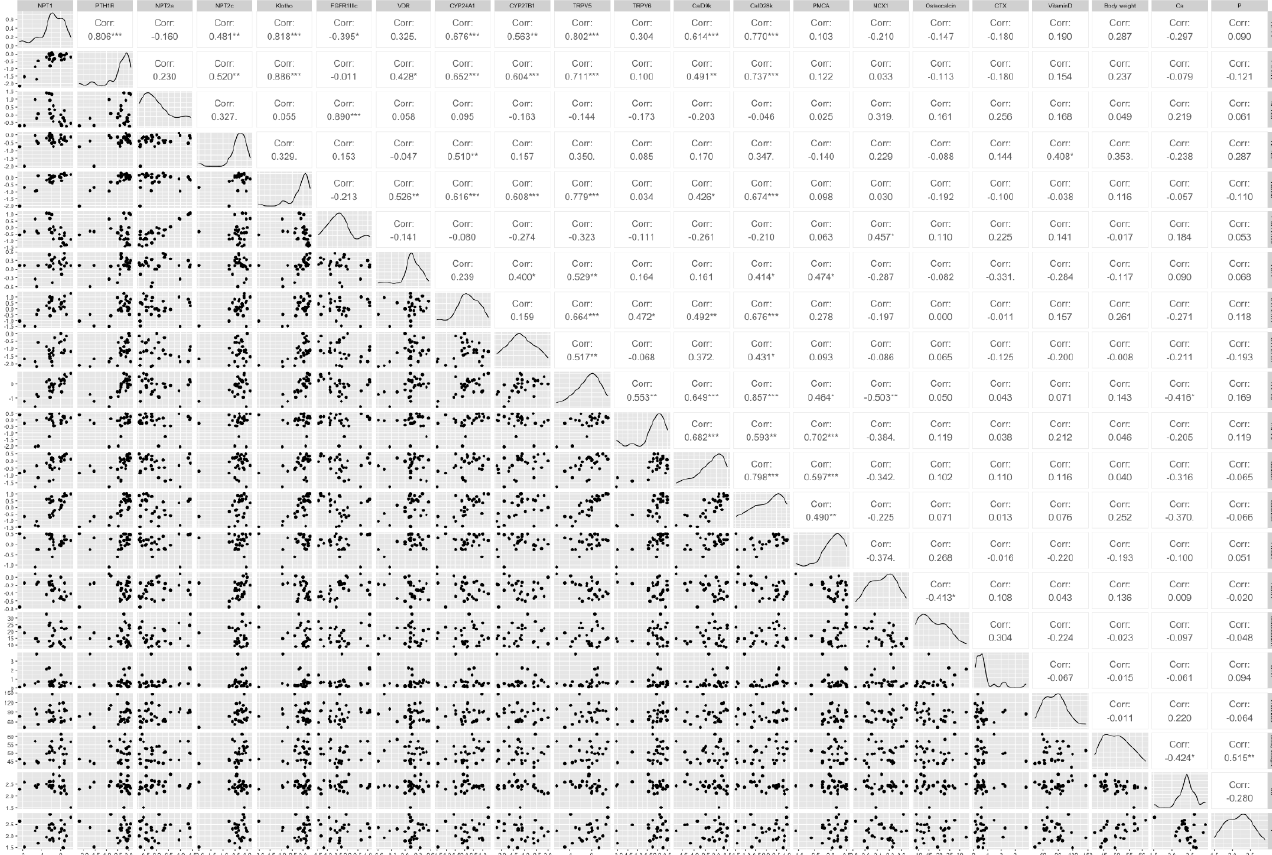
Figure 4. Pairwise Spearman’s correlation of phosphatonin and vitamin D-related transcripts (sodium-phosphate co-transporters ( NPT1 , NPT2a , NPT2c ), parathyroid hormone 1 receptor ( PTH1R ), α -klotho , fibroblast growth factor receptor 1 IIIc ( FGFR1IIIc ), vitamin D receptor ( VDR ), cytochrome P450 family 24 subfamily A polypeptide 1 ( CYP24A1 ), cytochrome P450 family 27 subfamily B polypeptide 1 ( CYP27B1 ), transient receptor potential cation channel subfamily V member 5 and 6 ( TRPV5 , TRPV6 ), calbindin D9k ( CalD9k ), calbindin D28k ( CalD28k ), plasma membrane calcium ATPase ( PMCA ), sodium calcium exchanger 1 ( NCX1 )) in ovine kidneys, serum analytes (calcium (Ca), phosphorus (P), 25-hydroxyvitamin D (Vitamin D), osteocalcin, C-terminal telopeptide (CTX), and body weight. Bottom and left indicates log 10 transformed renal gene fold expression. *** p < 0.001, ** p < 0.01, * p ≤ 0.05.